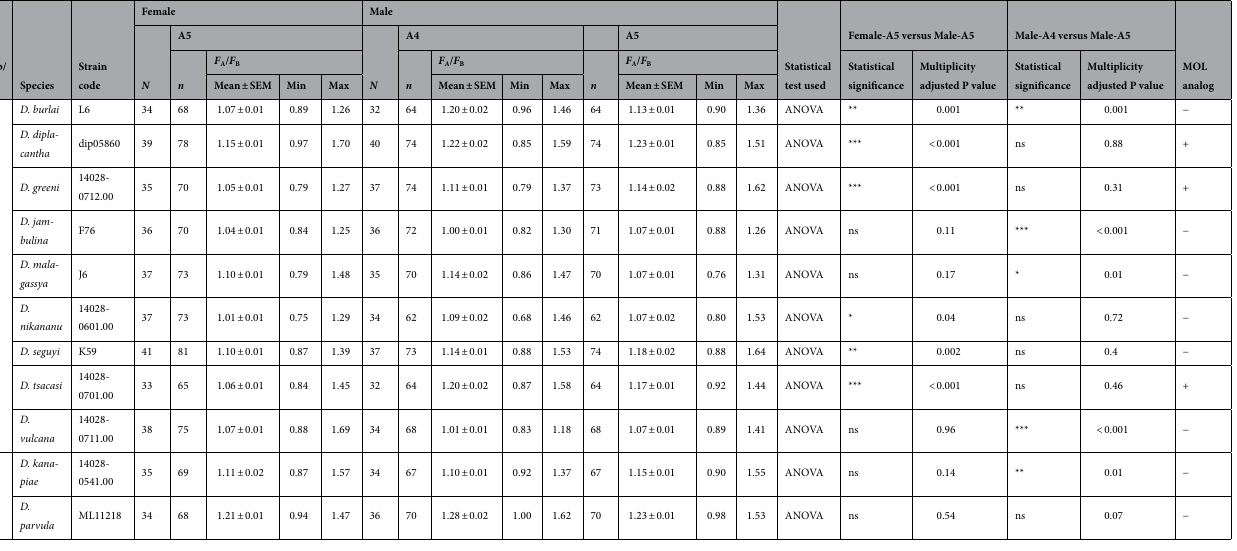
Table 1. Feret’s diameter of the largest muscle of abdominal segments in male and female flies of the montium group. N : The total number of individuals used in this analysis. n : The total number of A4 or A5 hemi- segments examined. F : Feret’s diameter ( F A and F B ), the longest distance of a target muscle. F A / F B : The Feret’s diameter ratio obtained by dividing the Feret’s diameter of the longest muscle ( F A ) by that of the medial- most conventional muscle ( F B ) in the same hemi-segment. When the mean F A / F B in males is larger than that in females at the statistically significant level of P < 0.001, we judge that the males have the MOL analog or without MOL as indicated by a "+" or